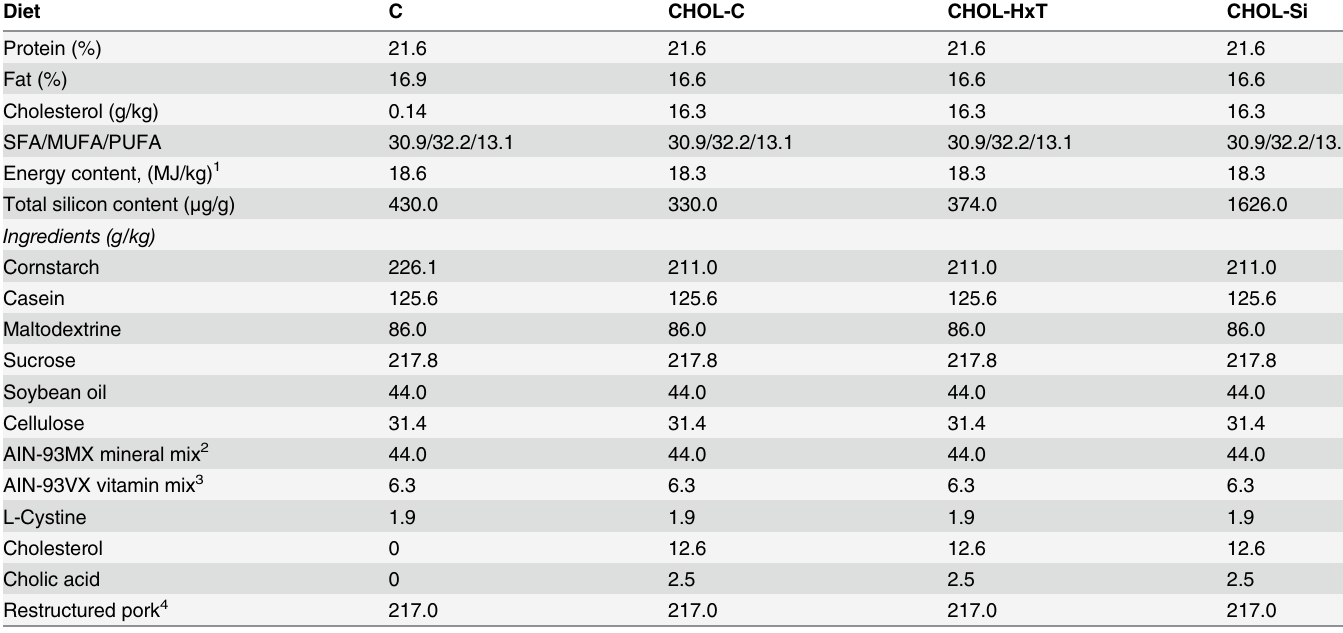
Table 1. Composition of the experimental diets fed to aged rats. Diet